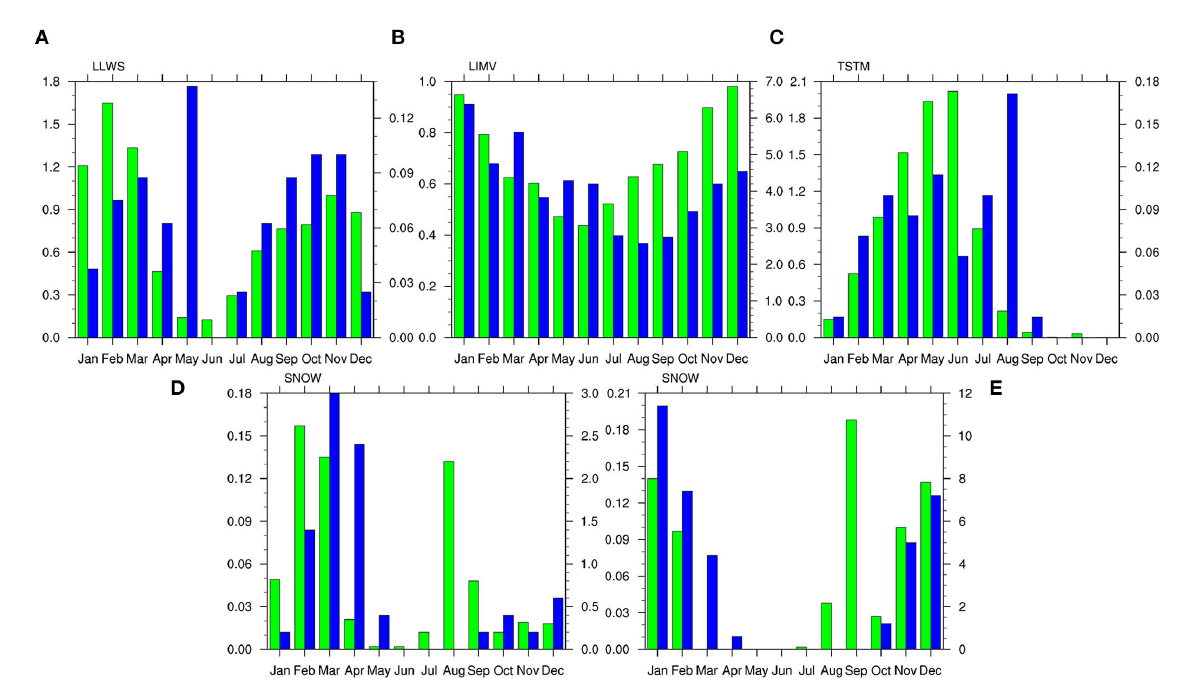
FIGURE13 Annual cycles of hazardous weather conditions obtained by the ERA5/ERA5-land reanalysis (unit: hours; left Y-axis; green bars) and observations (unit: days; right Y-axis; blue bars). (A) is the area-average LLWS at the airports in the north of eastern China. (B,C) are the area-average LIMV and TSTMs at the airports in the south of eastern China, respectively. (D,E) are the SNOW at Kongga, Lhasa, and Diwopu, Urumchi,